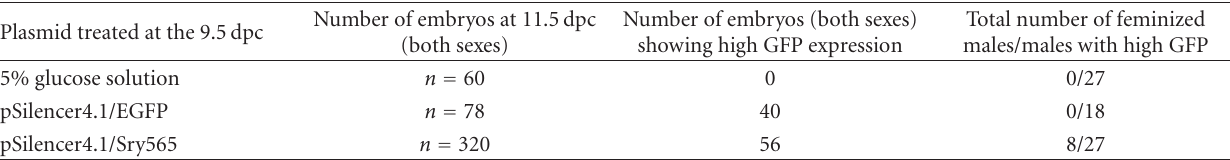
Table 1: 11.5 dpc Mouse embryos used to analysis of Sry knockdown. GFP expression was assessed macroscopically by examining whole urogenital systems under a dissecting microscope equipped with fluorescence optics. The density of GFP fluorescence was classified as low, medium, or high. Feminization was assessed by gonadal histology, immunofluorescent marker expression, or quantitative RT–PCR. Plasmid treated at the 9.5dpc